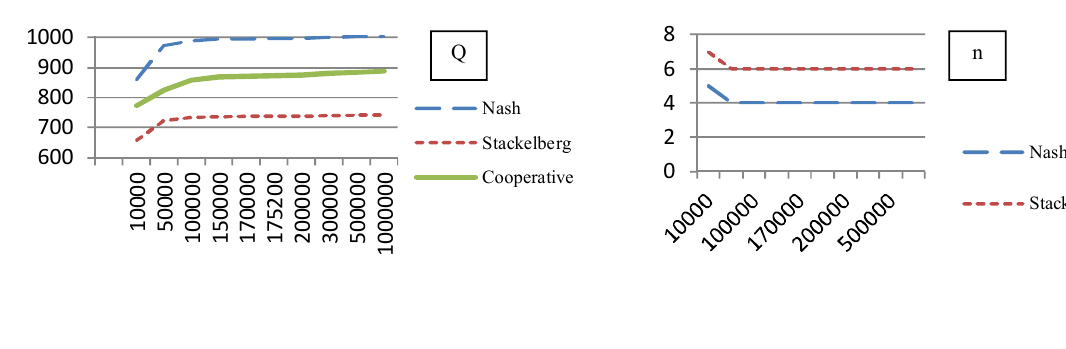
Fig. 3. Effect of  on  ∗ and